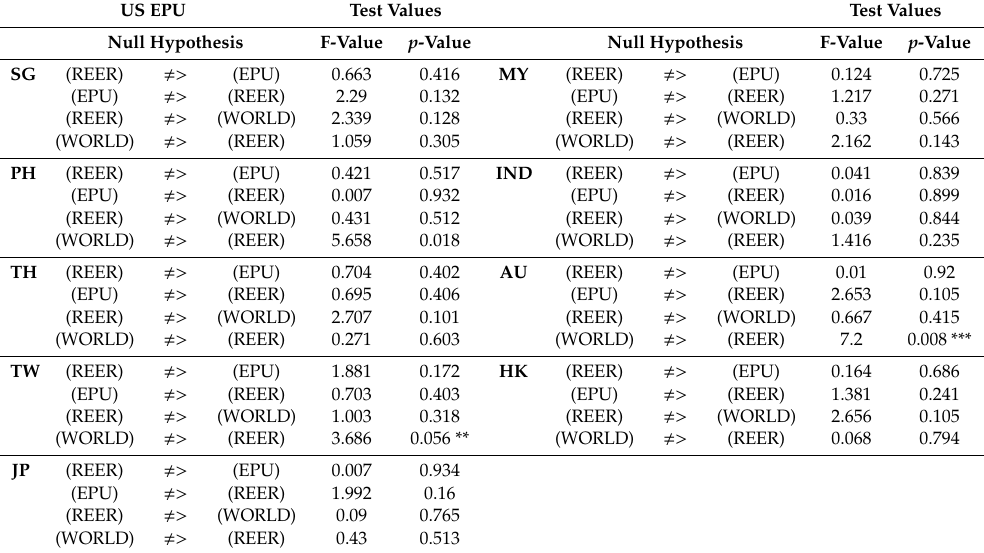
Table 8. Pairwise linear Granger-causality test between REERs and the US Economic Policy Uncertainty (EPU): January 1998–April